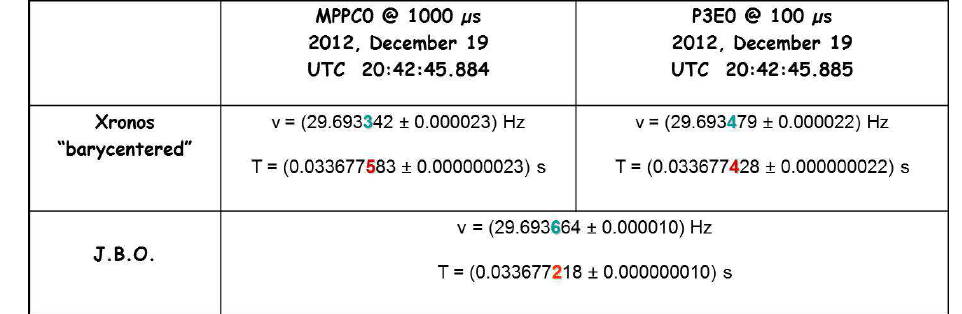
Figure 3: Fundamental frequency and period values of the Crab pulsar signal obtained by our data with applied the heliocentric corrections compared with those computed from JBO ephemeris. The uncertainties on the JBO values are due to a numerical interpolation procedure. The quoted errors on our data are statistical only.